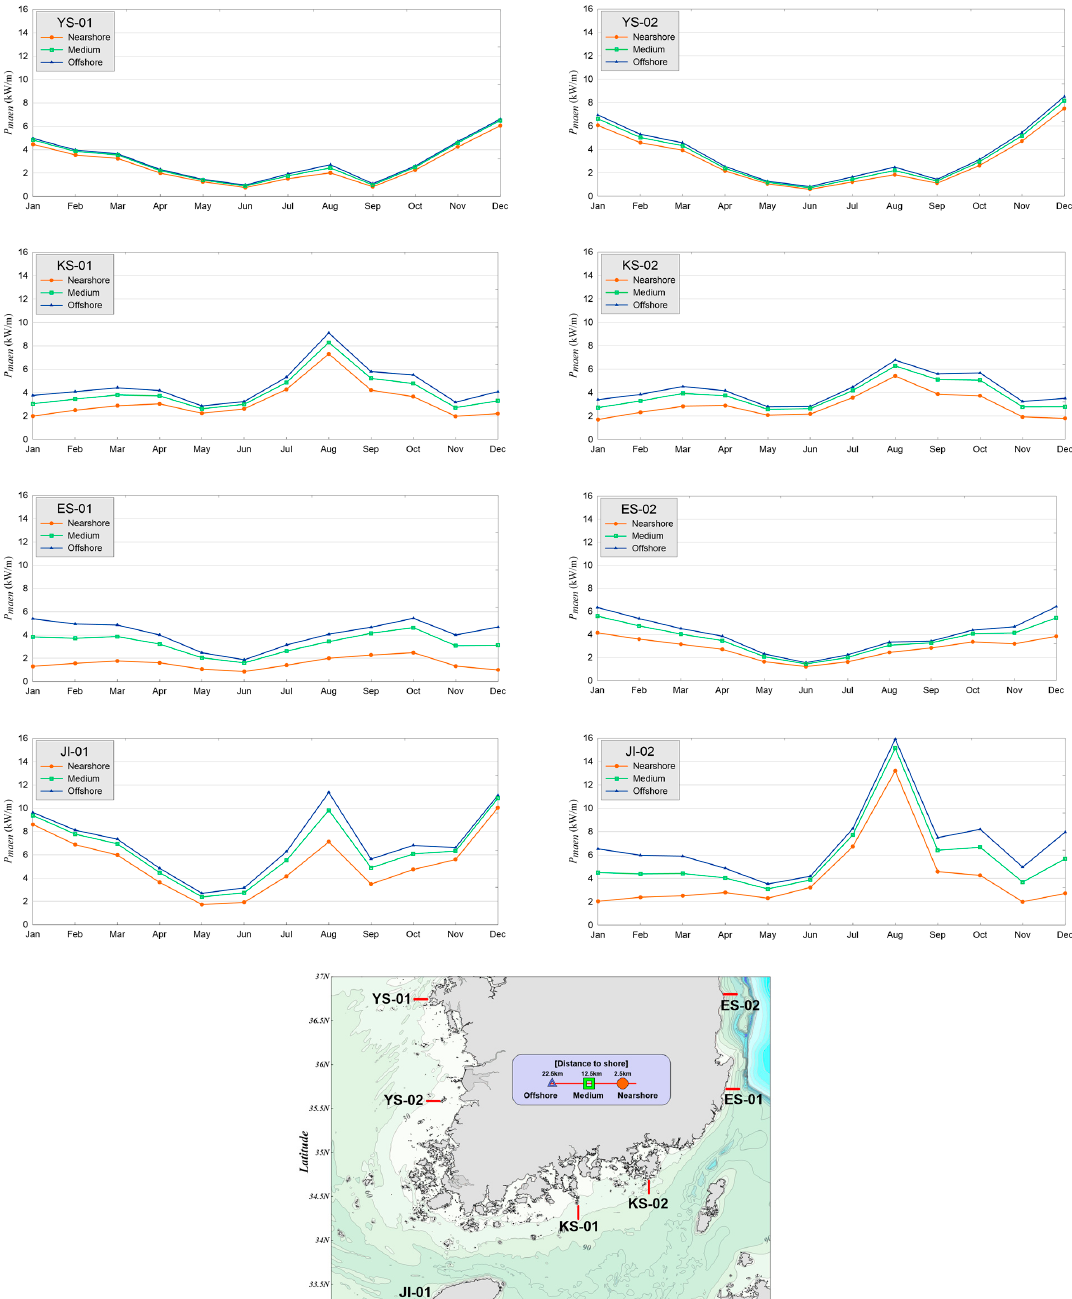
Figure 11. Time series of monthly mean wave energy computed at two selected locations for each region over 2007–2018. The orange, green, and blue lines denote the locations where the energies are computed; their distances from the shore are 2.5 (nearshore), 12.5 (medium), and 22.5 km (offshore), respectively.